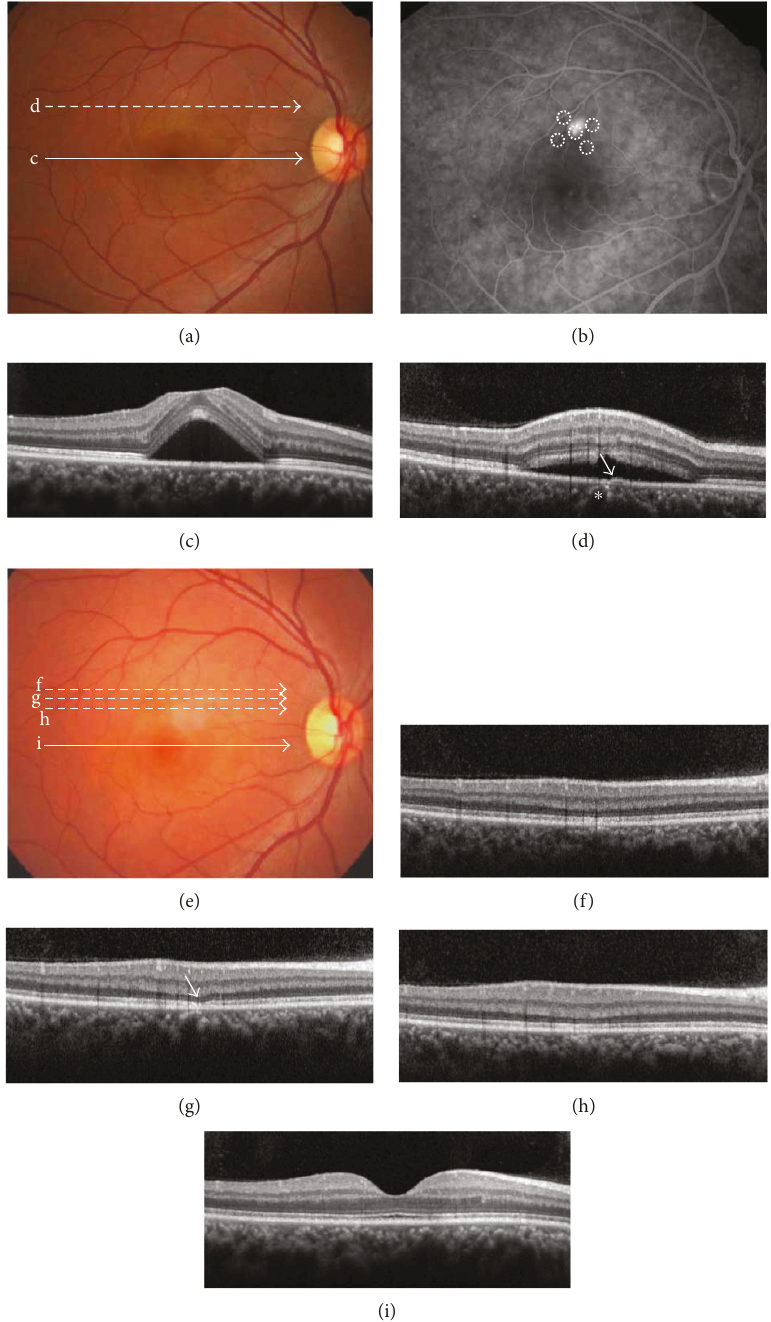
Figure 3: Fundus photographs (a, e) as well as fl uorescein angiographic (b) and optical coherence tomographic (OCT) (c, d, f – i) images of a 38-year-old patient with acute central serous chorioretinopathy treated with selective retina therapy (case number 5 in Tables 1 and 2). At diagnosis (a – d), best-corrected visual acuity (BCVA) was 20/25, and the patient complained of metamorphopsia. At the location of leakage, a shallow pigment epithelial detachment (PED) (d) (arrow) was observed adjacent to the pachy vessel (d) (asterisk). Three months after treatment (e – i), subretinal fl uid had completely resolved and BCVA had improved to 20/20. A PED had resolved after treatment with thinning of the ellipsoid zone at the location of previous leakage (panel g, arrow). There was no notable treatment-related retinal pigment epithelial damage (f-g). The dotted circles in (b) indicate laser spots. Lowercase letters in panels (a) and (e) indicate OCT scanning lines for panels with the same